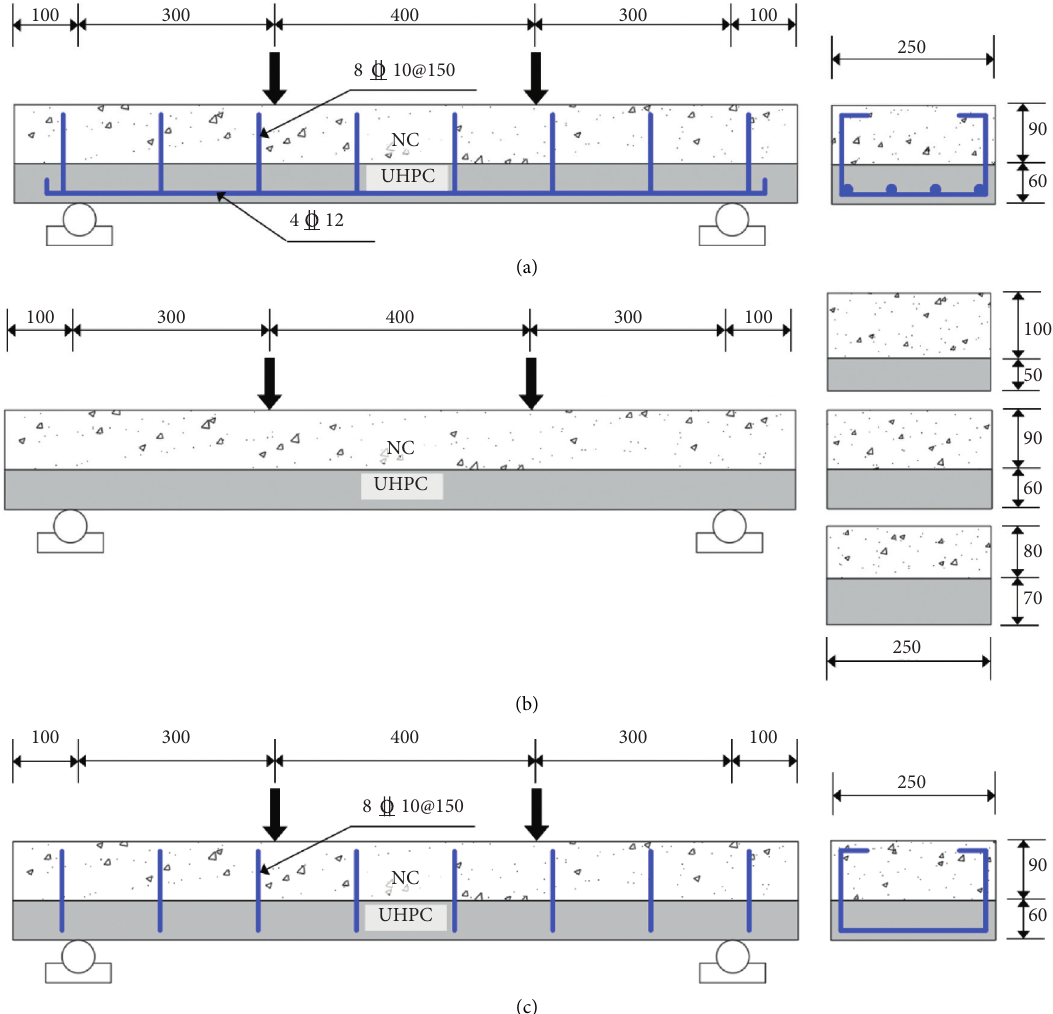
Figure 2: Illustrations of the tested specimens (unit: mm). (a) Specimen U60-LS. (b) Specimens U50, U60, and U70. (c) Specimen U60-S.